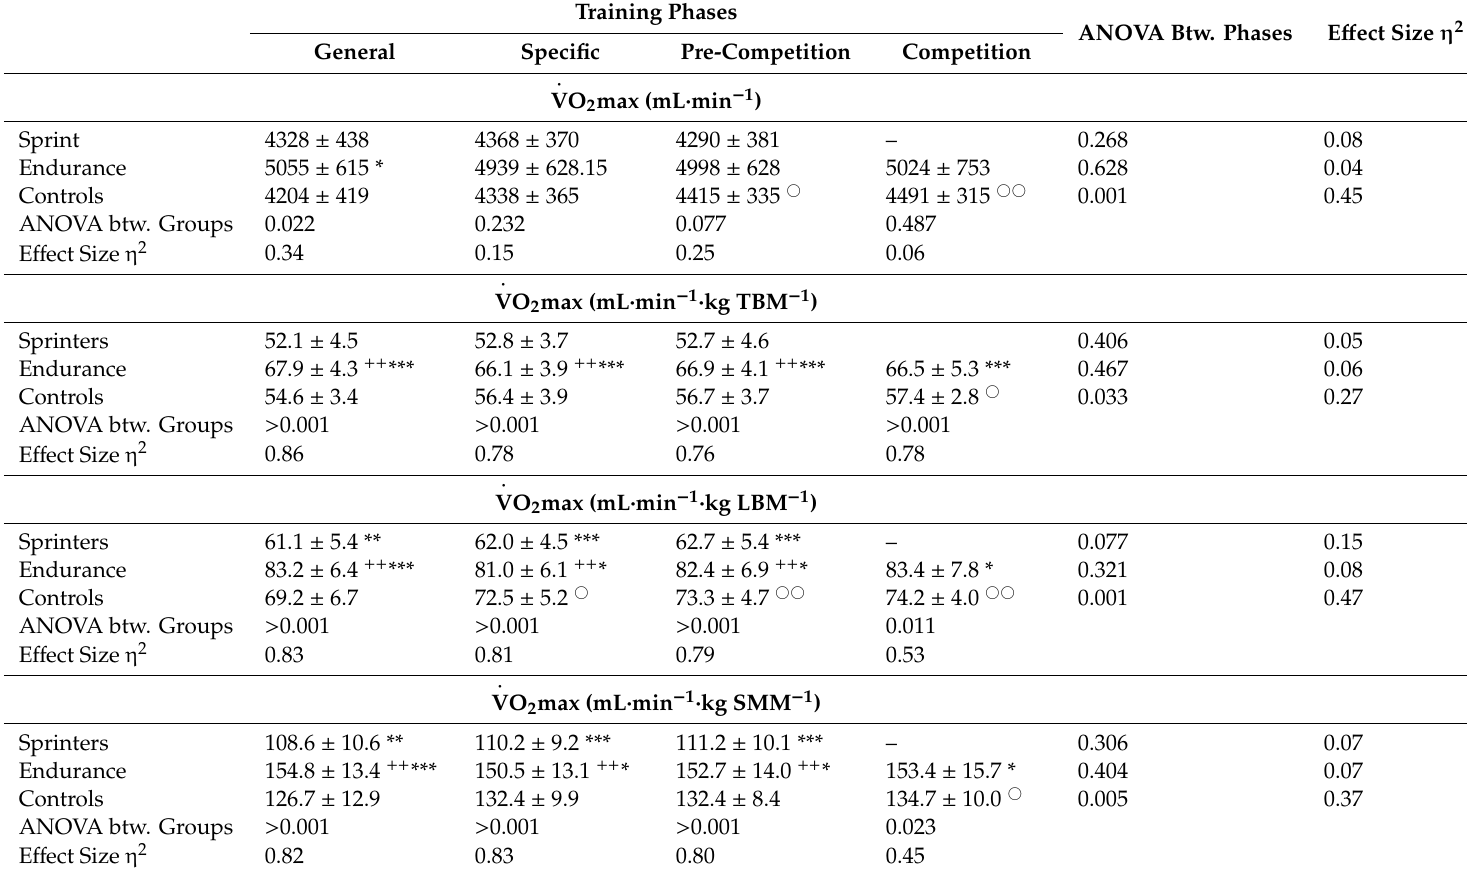
Table A2. Changes in maximal oxygen uptake (absolute and relative values) between consecutive phases of the annual training cycle in athletic groups and